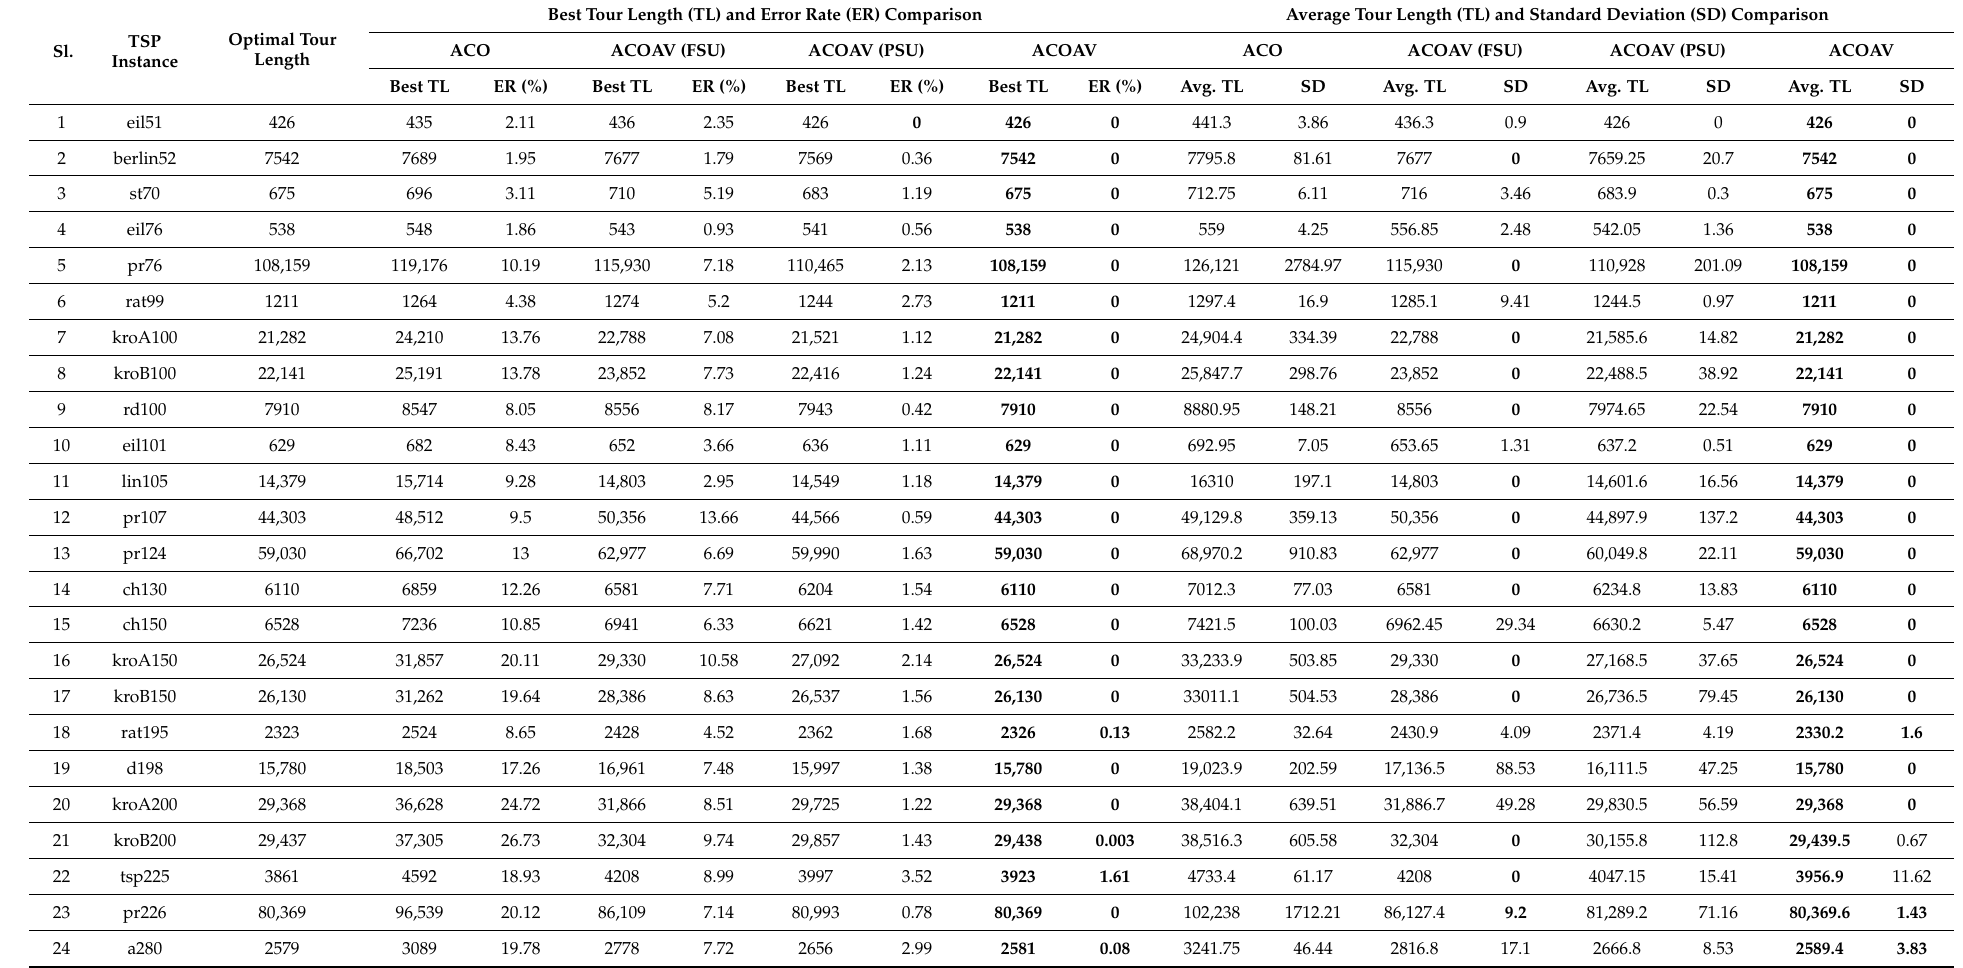
Table 1. Performance Comparison among ACO, ACOAV (FSU), ACOAV (PSU), and ACOAV on 20